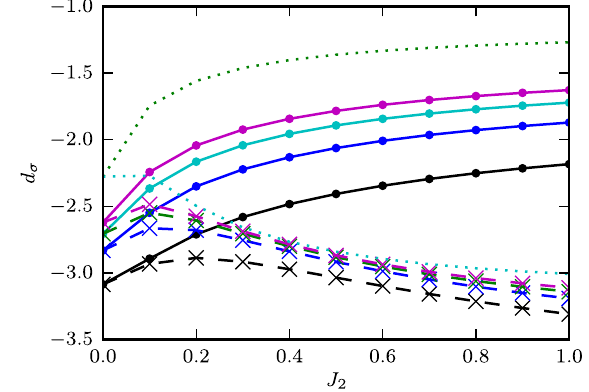
FIG. 3. Dependence of the exponent d σ on the Majorana coupling J 2 for a fixed Kondo coupling J 3 =t ¼ 0 . 5 and J 1 ¼ h ¼ 0 . Solid lines correspond to d ↑ , dashed lines to d ↓ . System sizes are L ¼ 32 , 64, 96, 128, and an extrapolation to L → ∞ is shown as a dotted